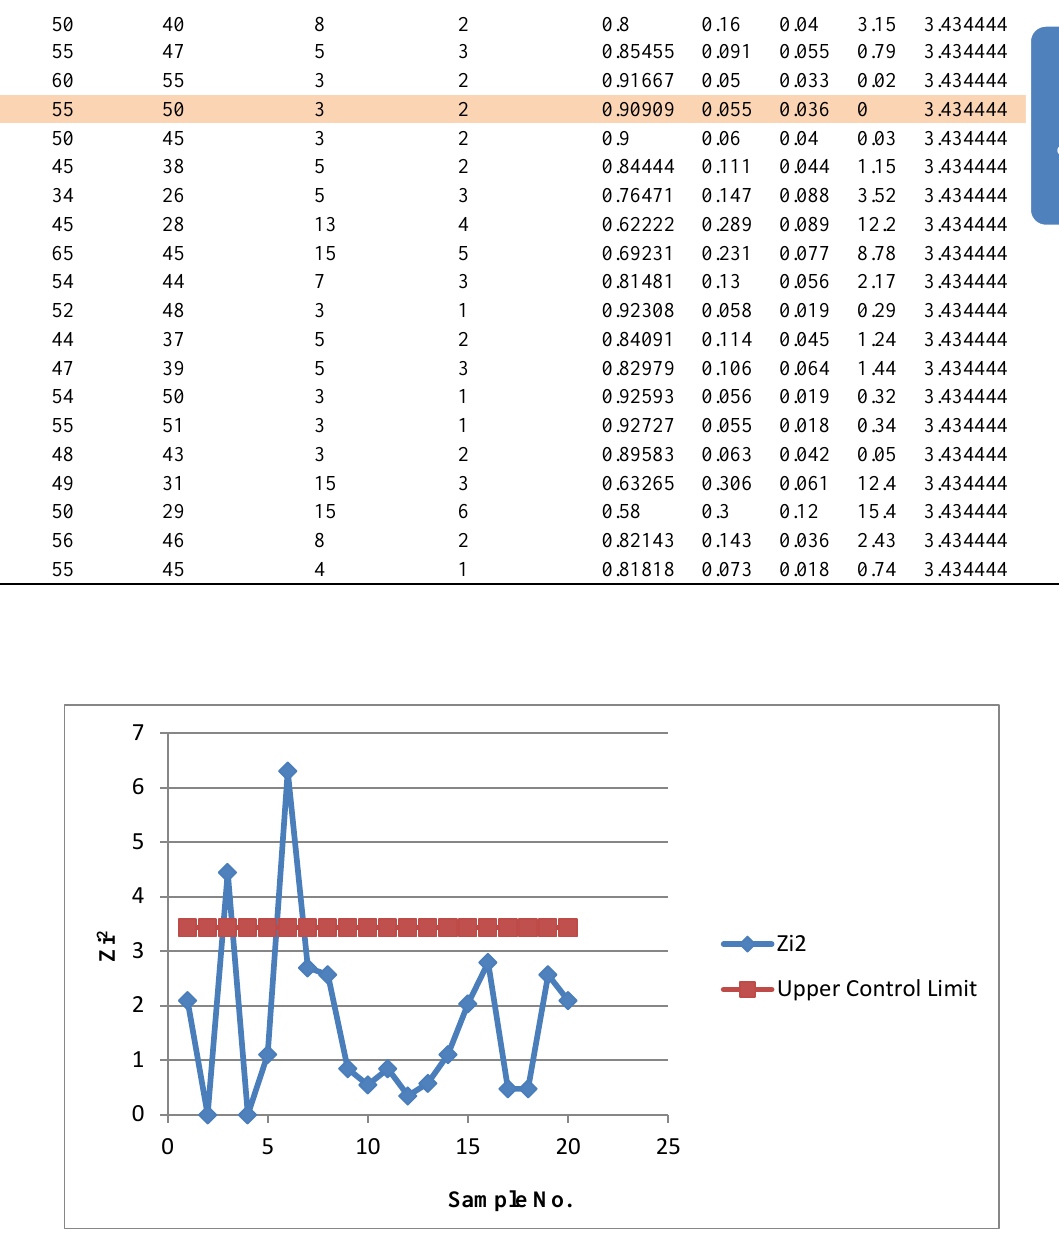
Figure 11. Generalized P-Chart from Marcucci Approach for Constant Sample